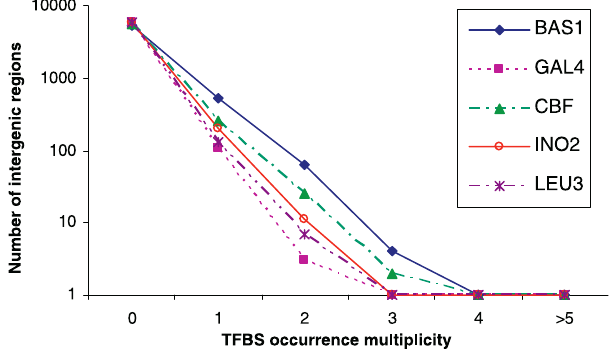
Figure 9. The Distribution of TFBS Occurrence Multiplicities per Intergenic Region in S. cerevisiae Is Shown for Five TFs Whose TFBS Motif Was Experimentally